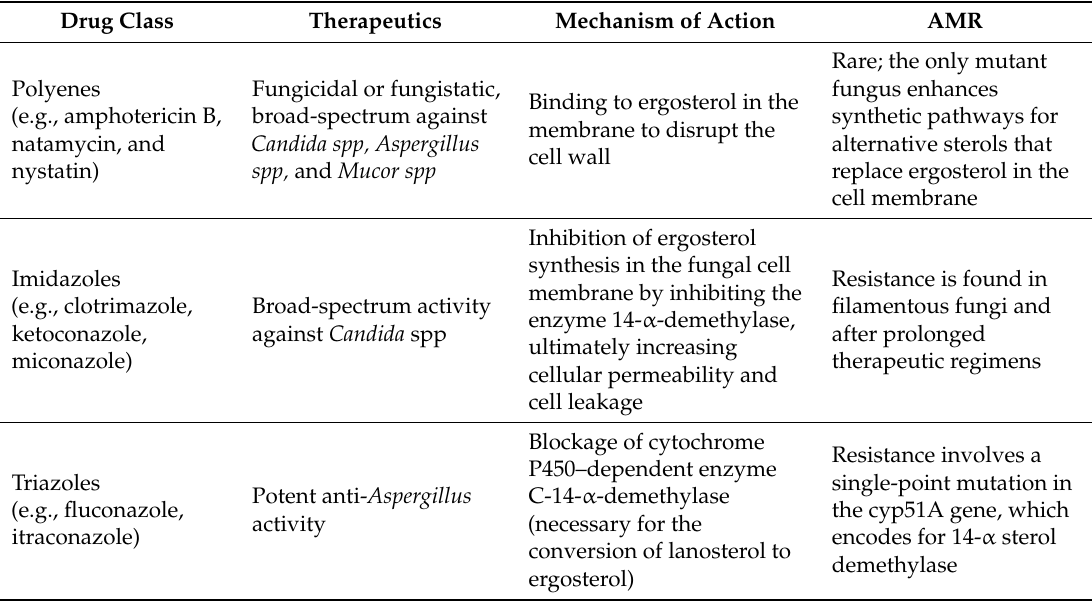
Binding to ergosterol in the membrane to disrupt the cell wall Inhibition of ergosterol synthesis in the fungal cell membrane by inhibiting the enzyme 14- α -demethylase, ultimately increasing cellular permeability and cell leakage Blockage of cytochrome P450–dependent enzyme C-14- α -demethylase (necessary for the conversion of lanosterol to ergosterol)